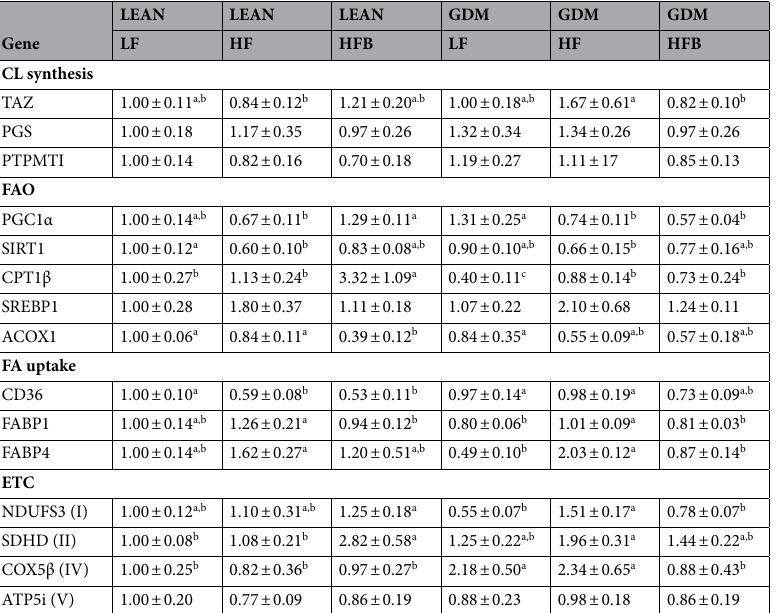
Table 3. PCR analysis of liver. mRNAs were measured in the liver of offspring following 12-weeks of the indicated diet (LF, HF, HFB). Values are means ± SEMs (n = 7), means without a common letter differ,